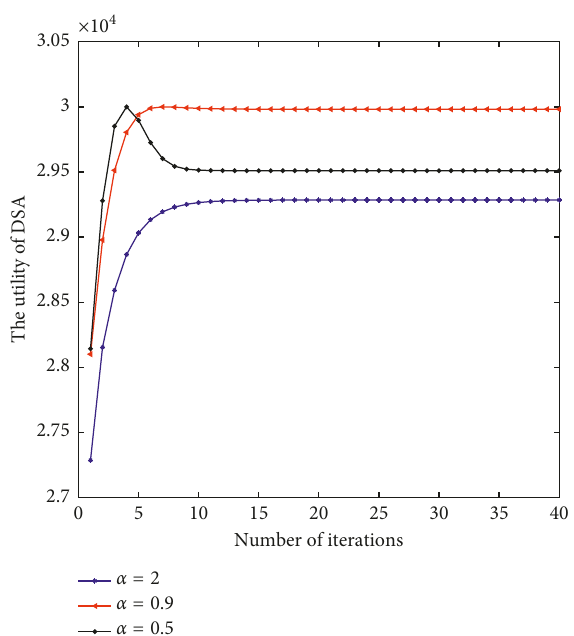
Figure 5: Different user utility changes with the iterative process.